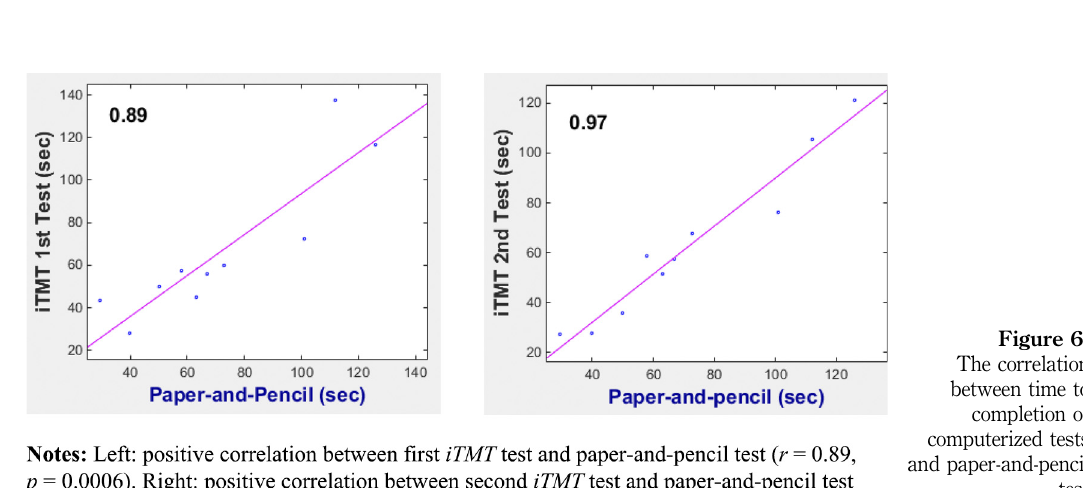
segment length and visual interference